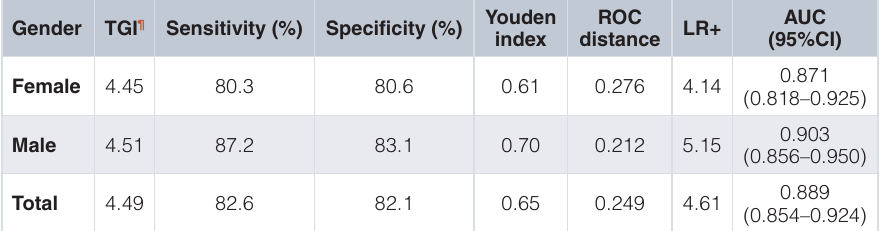
Table 4. Cut-off points for triglyceride-glucose index (TGI) selected in the reference population and by gender, in Maracaibo city, Venezuela.